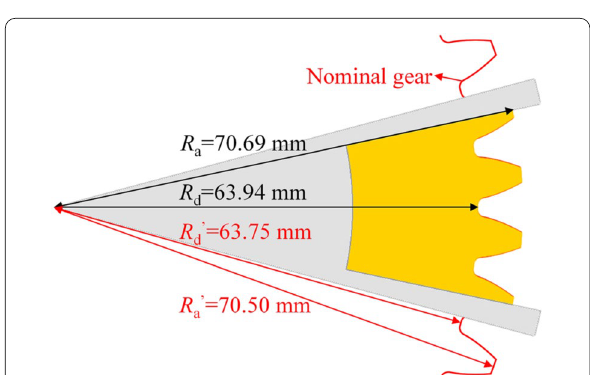
Figure 9 Comparison between the tooth profile obtained by simulations and the standard gear